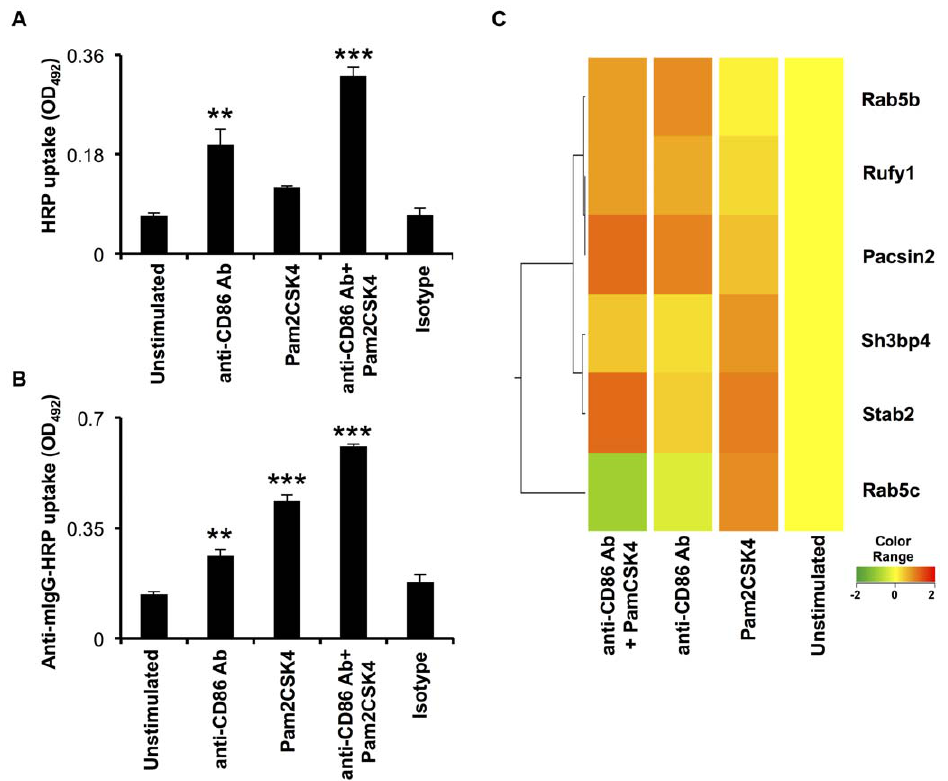
Figure 5. Triggering through CD86 and TLR-2 enhances pinocytosis and receptor mediated endocytosis abilities of RB cells. (A, B) RB cells of BALB/c mice were stimulated with anti-CD86 Ab and Pam2CSK4 and pulsed with (A) soluble HRP and (B) anti-mouse IgG-HRP. The antigen was chased at 37 u C for 30 minutes and internalization of antigen was determined colorimetrically. Values shown in the graphs were normalized against experimental blanks and control cells (maintained at 4 u C and lysed). The data represents mean 6 SEM of one of the 2–3 individual experiments. ‘*’, ‘**’, ‘***’ indicates p , 0.05, p , 0.01, p , 0.001, respectively. (C) Dendrograms represent modulation in the expression of genes encoding for molecules involved in endocytosis. Scale bar: 2 2 to +